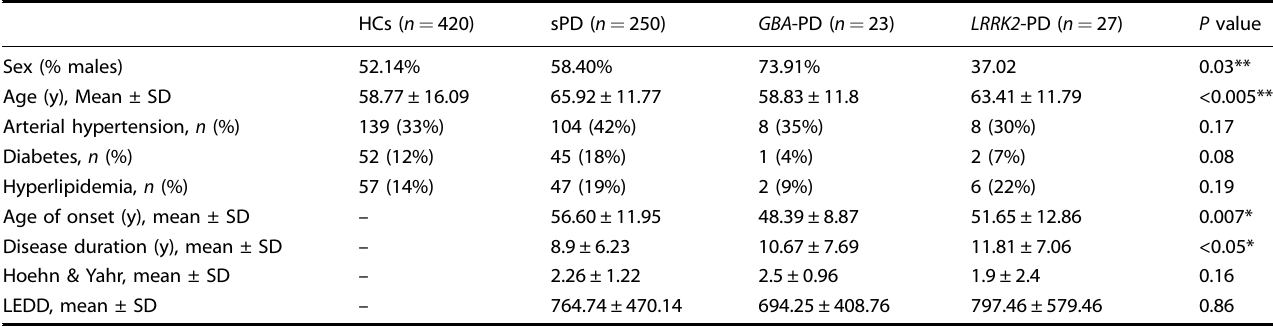
Table 2. Demographic and clinical data of healthy controls and Parkinson ’ s disease